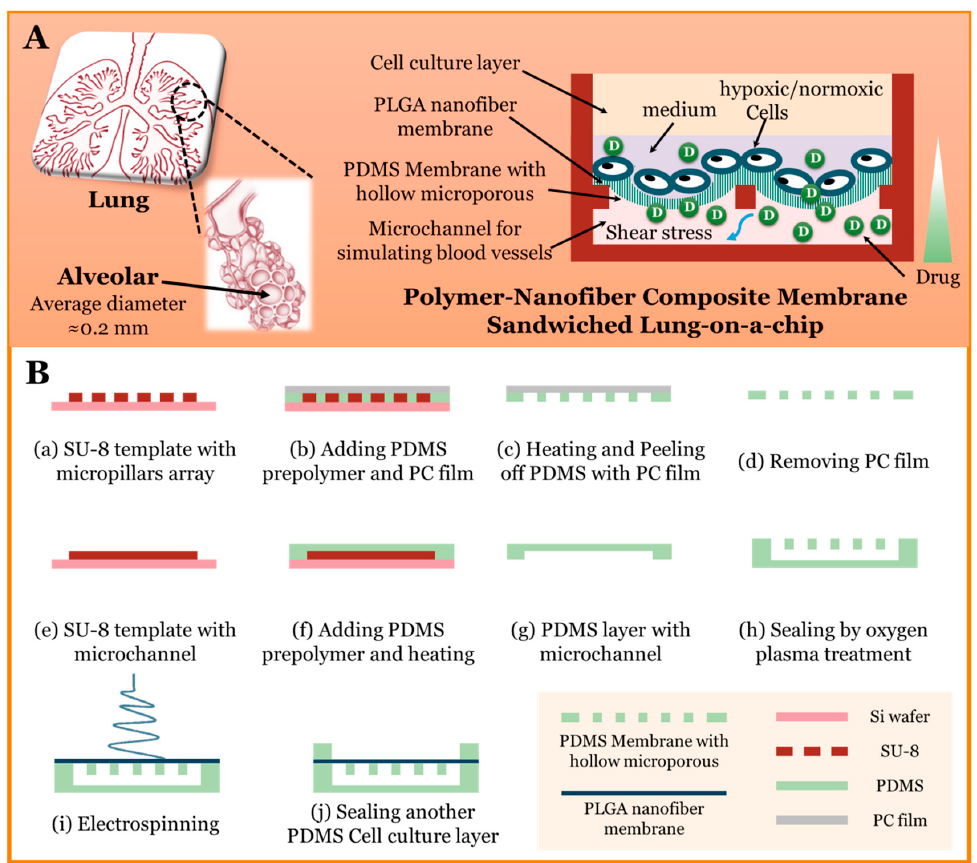
Figure 1. ( A ) Schematic diagram of chip design; ( B ) schematic diagram of microchip fabrication Figure1. ( A )Schematicdiagramofchipdesign; ( B processes.